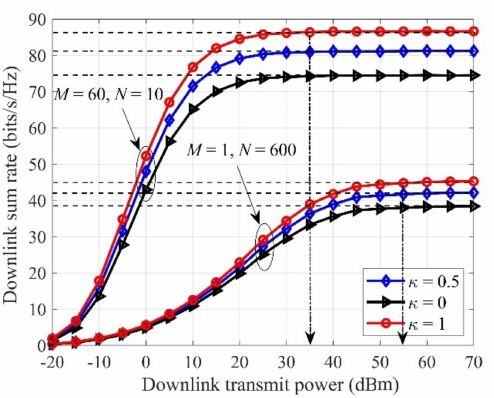
Figure 2. Downlink sum-rate versus the transmitted power with different antenna configurations, with MN = 600, K = 10..